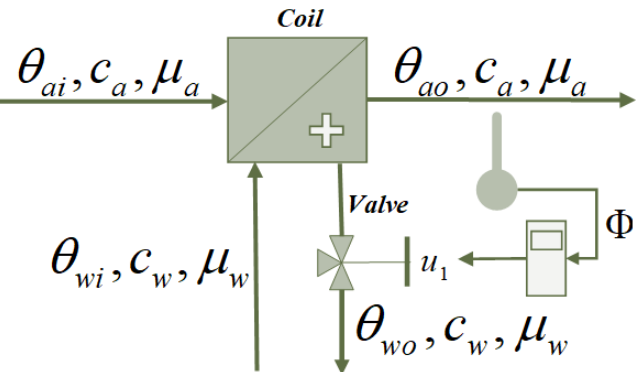
Figure 1. Schematic of the heating coil unit (HCU) of the